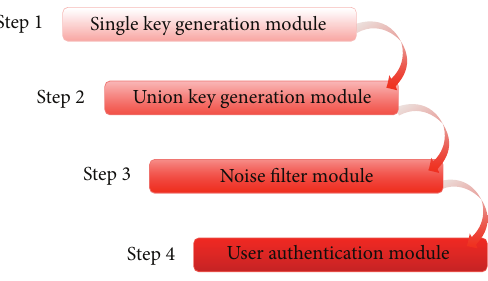
Figure 3: RLS authentication